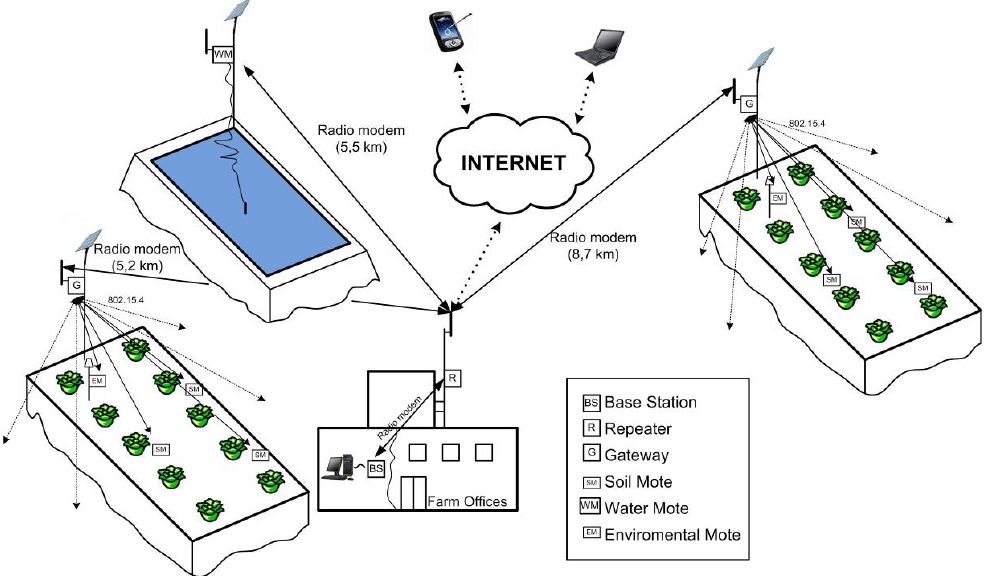
Figure 7. Illustration of the on-going implementation of an in-field data acquisition network, based on the GAIA motes in a precision horticulture